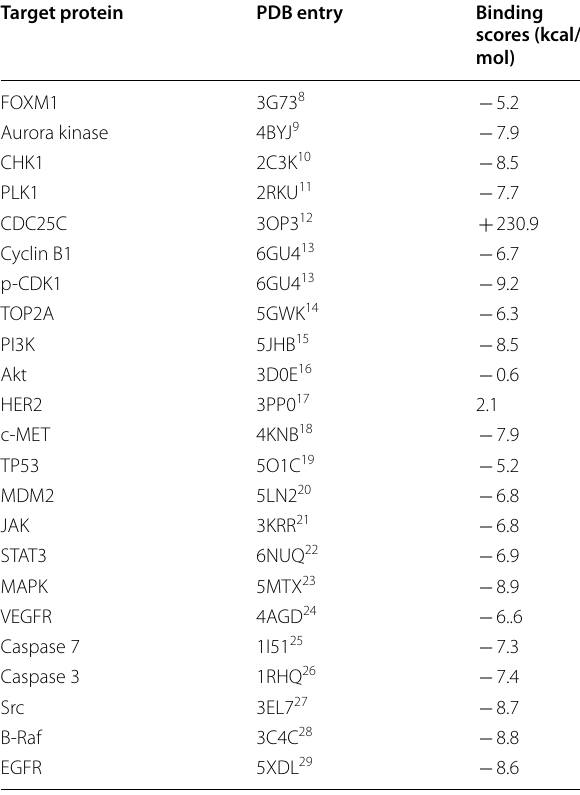
scores (kcal/ mol)